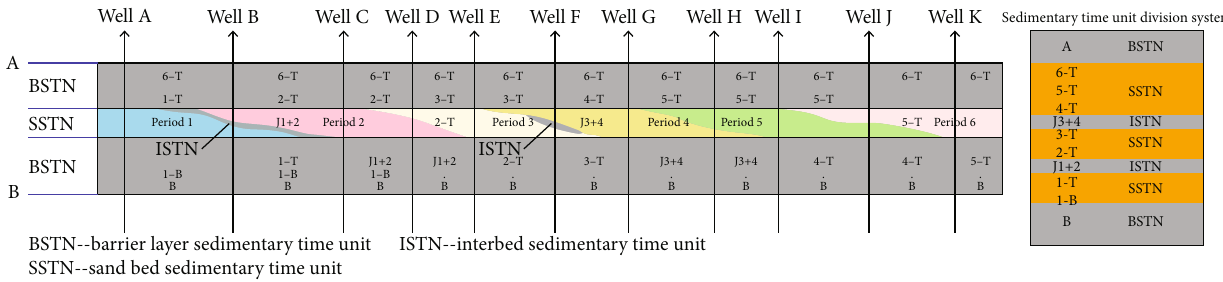
Figure 9: Schematic diagram of “ sandwich ” layer point coincidence modeling